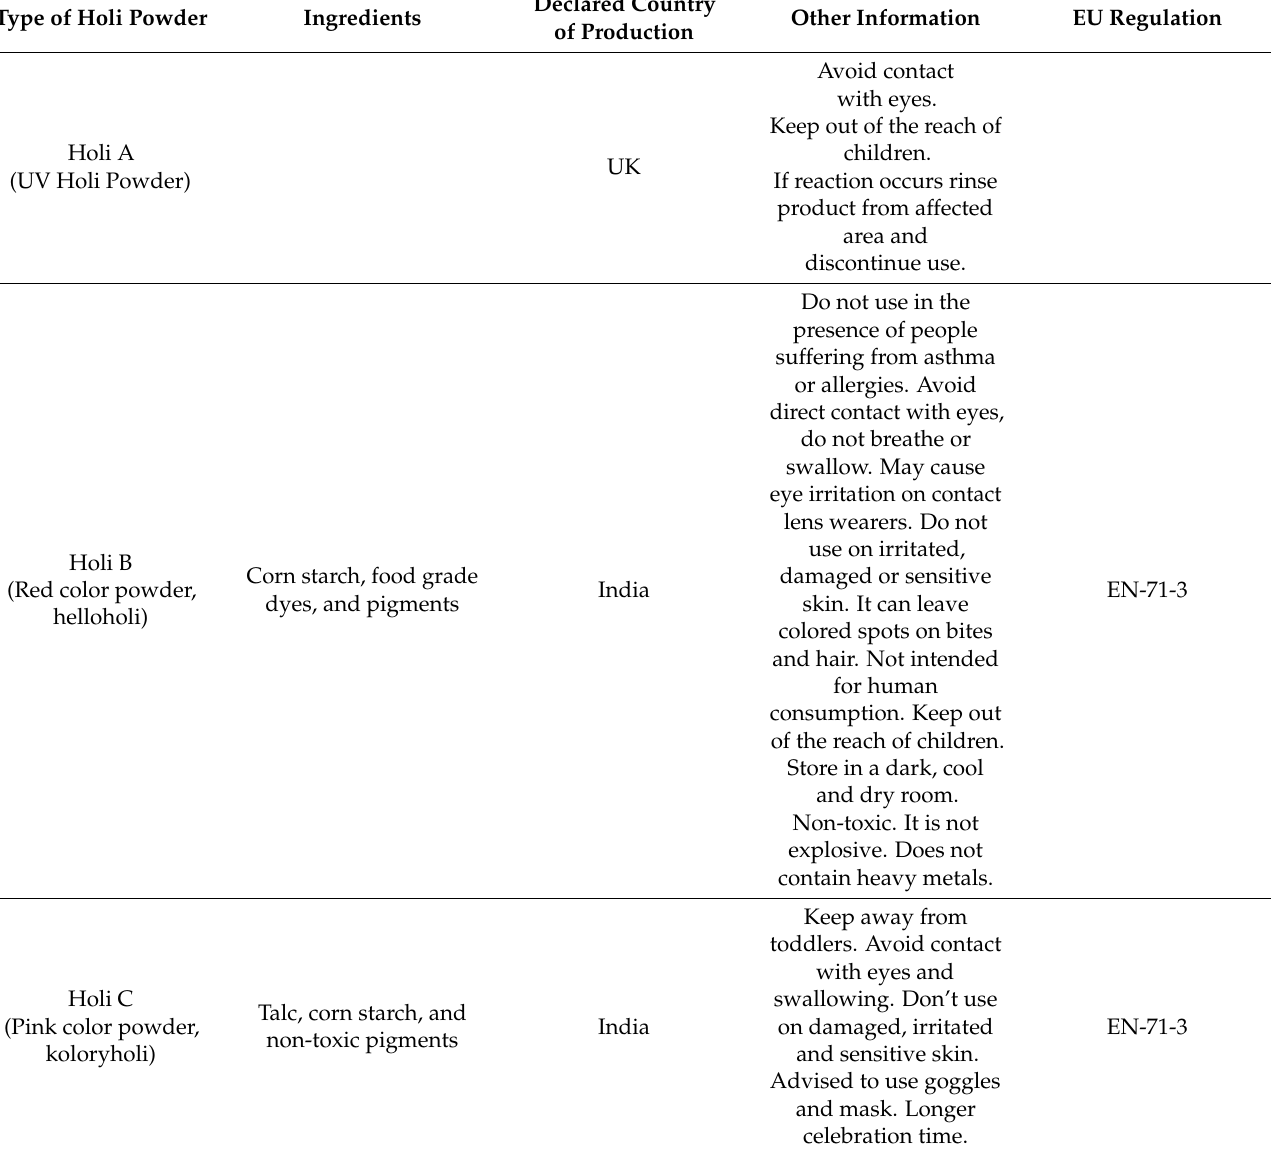
Table 1. Available information on specific Holi colors, either provided on the product itself or available online. Type of Holi